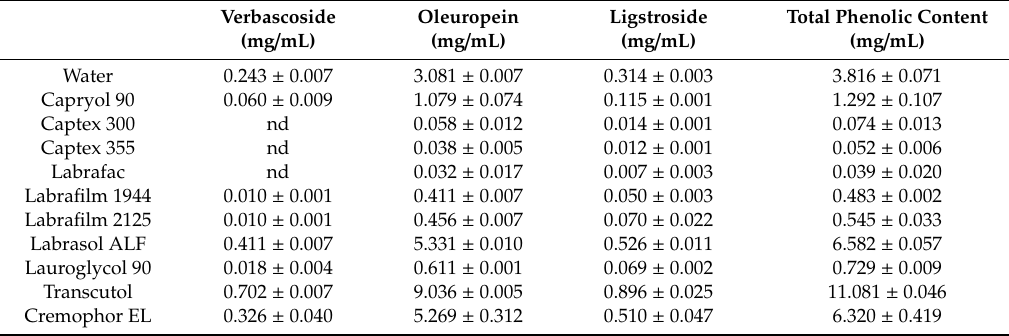
Table 2. Solubility of the main phenolic compounds of the olive extract in di ff erent vehicles. Data are expressed as mean ± sd from three independent measurements.